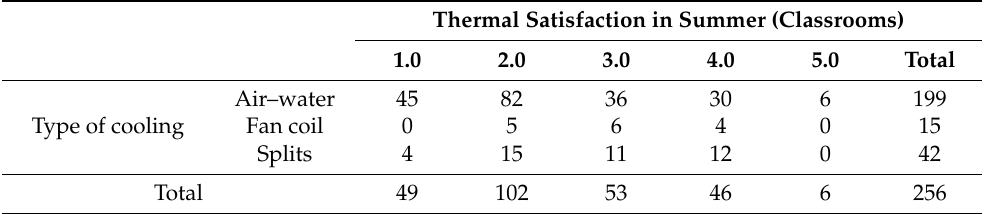
Table 5. Contingence table for thermal satisfaction in summer (classrooms) and type of cooling.